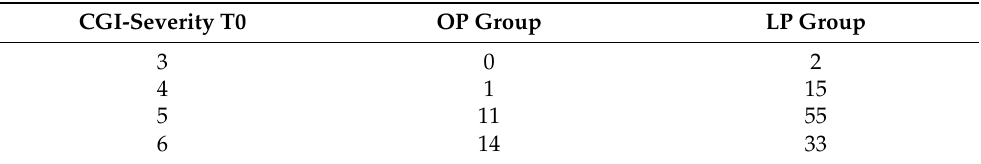
Table 2. CGI-Severity distribution at T0.